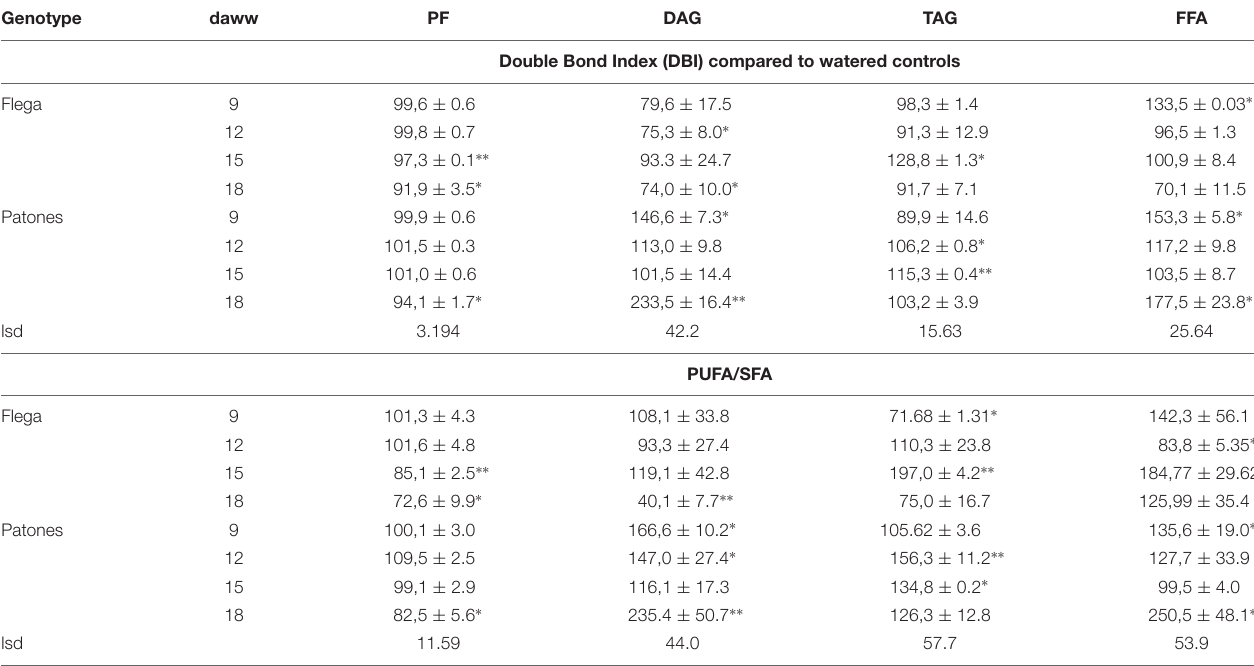
TABLE 1 | Double bond index (DBI) and ratio between polyunsaturated and saturated fatty acid (PUFA/SFA) for polar lipid fraction (PF), diacylglycerides (DAG), triacylglycerides (TAG) and free fatty acids (FFA) in oat genotypes Flega (susceptible) and Patones (tolerant) during a time course of increasing water stress at 9, 12, 15, and 18 days after withholding water (daww). Genotype daww PF DAG TAG